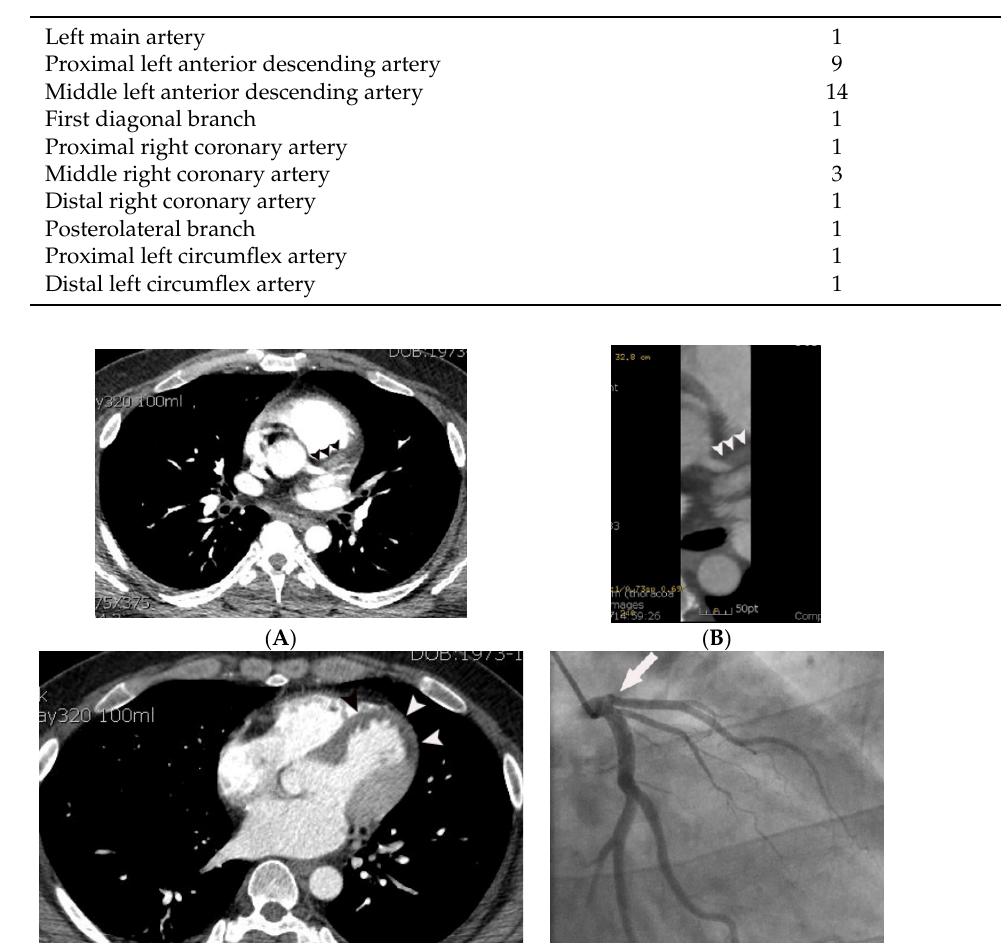
Probable artifact or equivocal MPD (CT score of 1) Parentheses indicate percentage. MPD indicates myocardial perfusion defect. Table 3. Location of culprit lesion on coronary angiography.